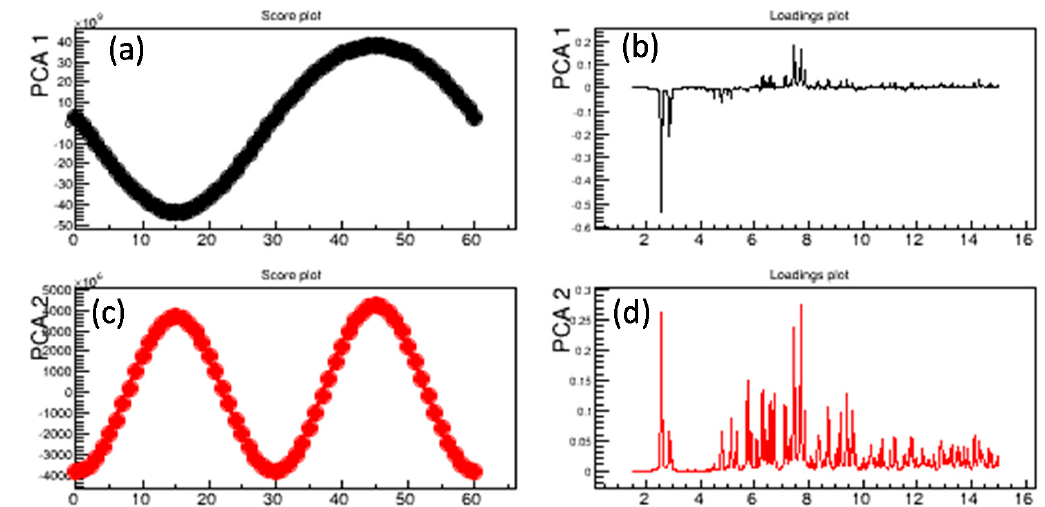
Figure 5. Example of PCA decomposition applied to in situ X-ray powder diffraction data. Scores ( a ) and loadings ( b ) of the first principal component (PC1); scores ( c ) and loadings ( d ) of the second principal component (PC2). A sinusoidal stimulus was applied during the in situ experiment.